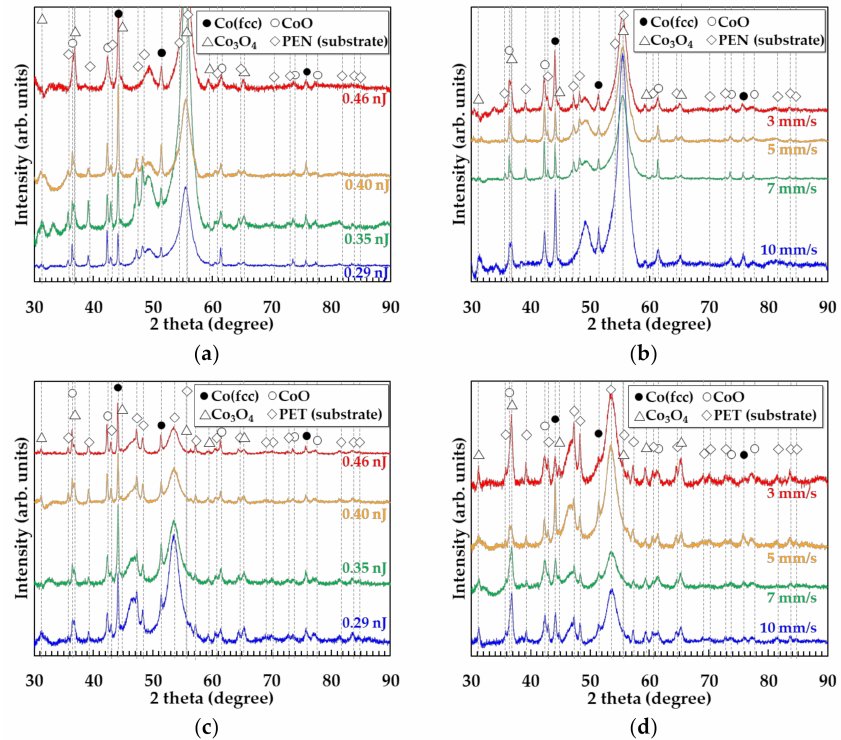
Figure 5. Crystal structures of the patterns fabricated on the PEN substrates ( a ) at a scanning speed of 5 mm/s and pulse energy in the range 0.29–0.46 nJ, and ( b ) with a scanning speed in the range 3–10 mm/s and a pulse energy of 0.29 nJ. Crystal structures of the patterns fabricated on PET substrates ( c ) at a scanning speed of 5 mm/s and pulse energy in the range 0.29–0.46 nJ, and ( d ) with a scanning speed in the range 3–10 mm/s and a pulse energy of 0.29 nJ.